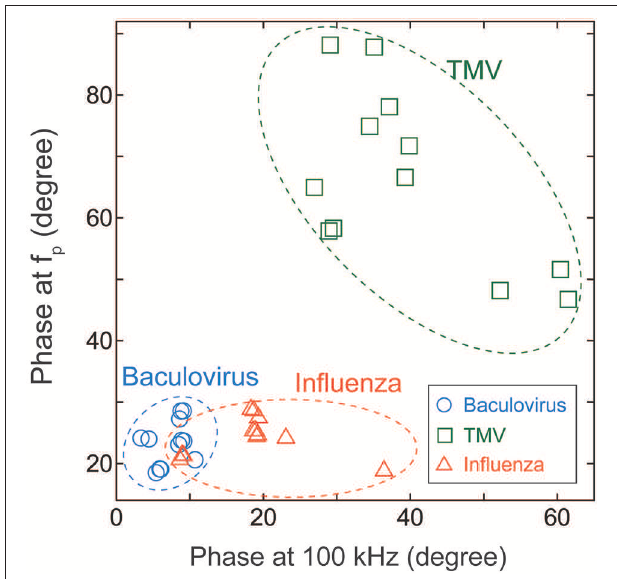
FIGURE 6 | Cluster map of Baculovirus, TMV, and influenza virus. The data were obtained for virus concentrations of 10 11 –10 14 virions/mL, and plotted with the phase at 100kHz along the horizontal axis and the phase at the peak frequency of the imaginary component of impedance along the vertical